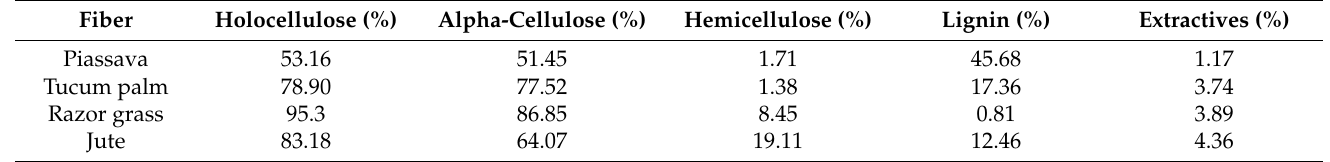
Table 2. Chemical composition of untreated fibers.